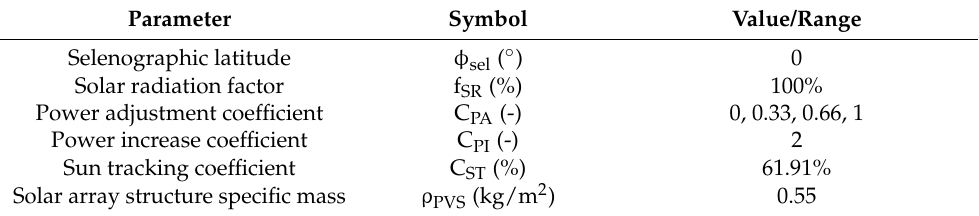
Table 17. Parameters for the base power adjustment coefficient study.